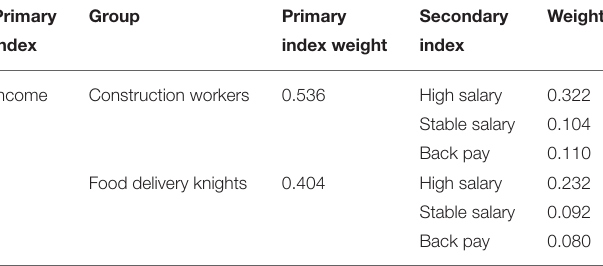
TABLE 3 | Weights of index “income”.